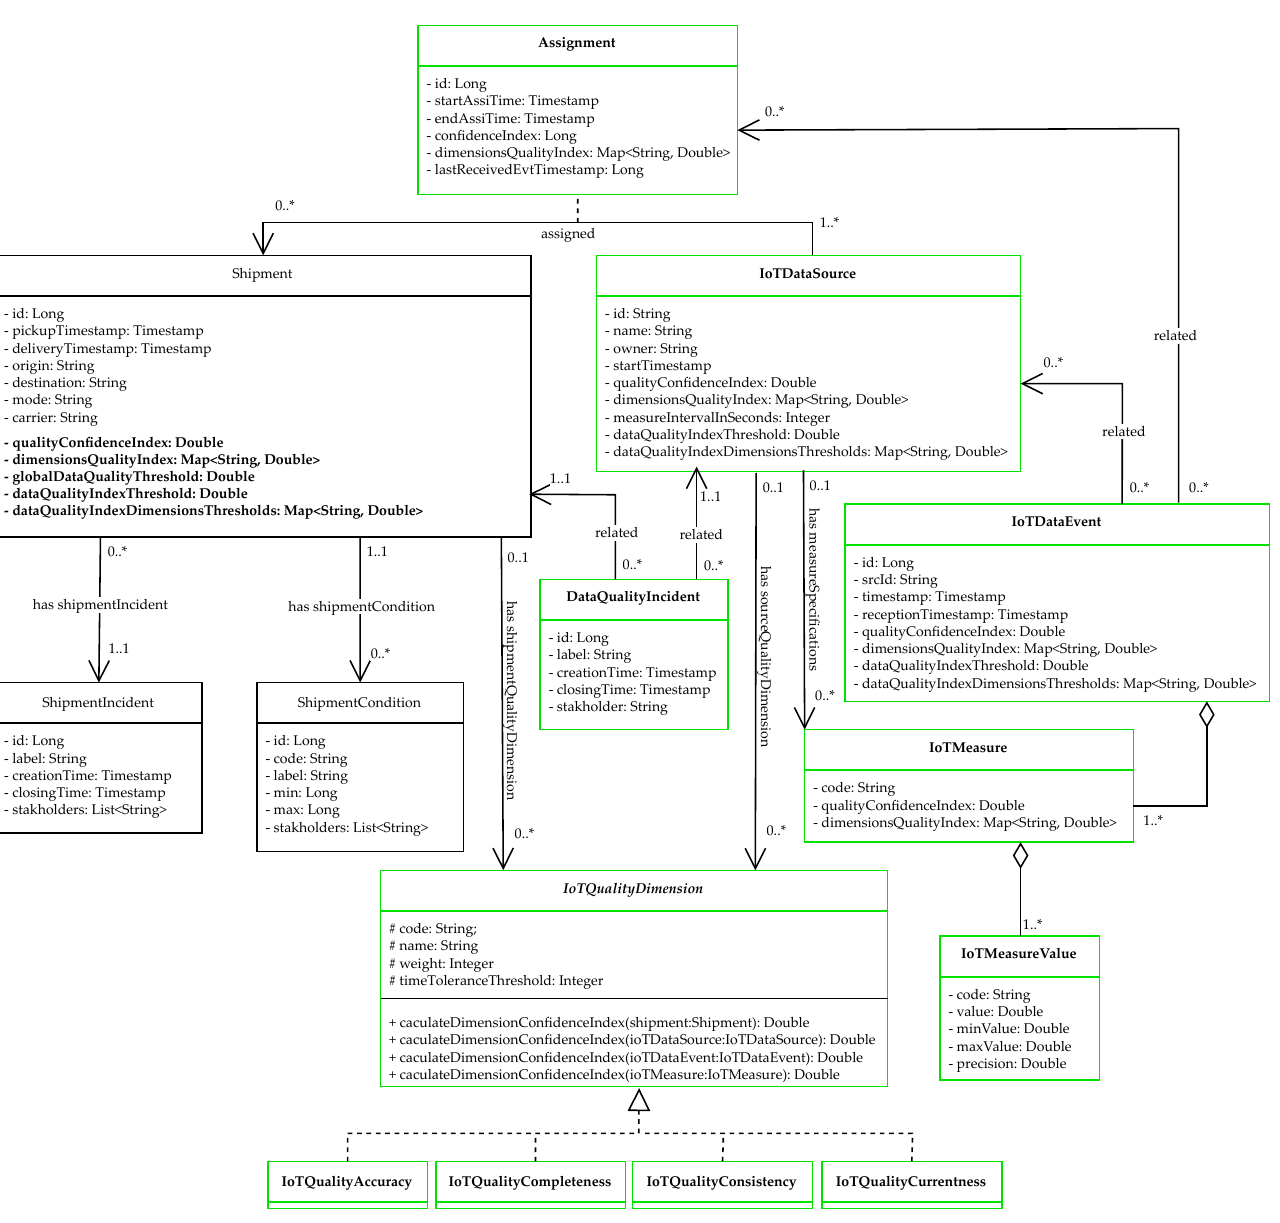
Figure 1. IoT Data Quality Entity class